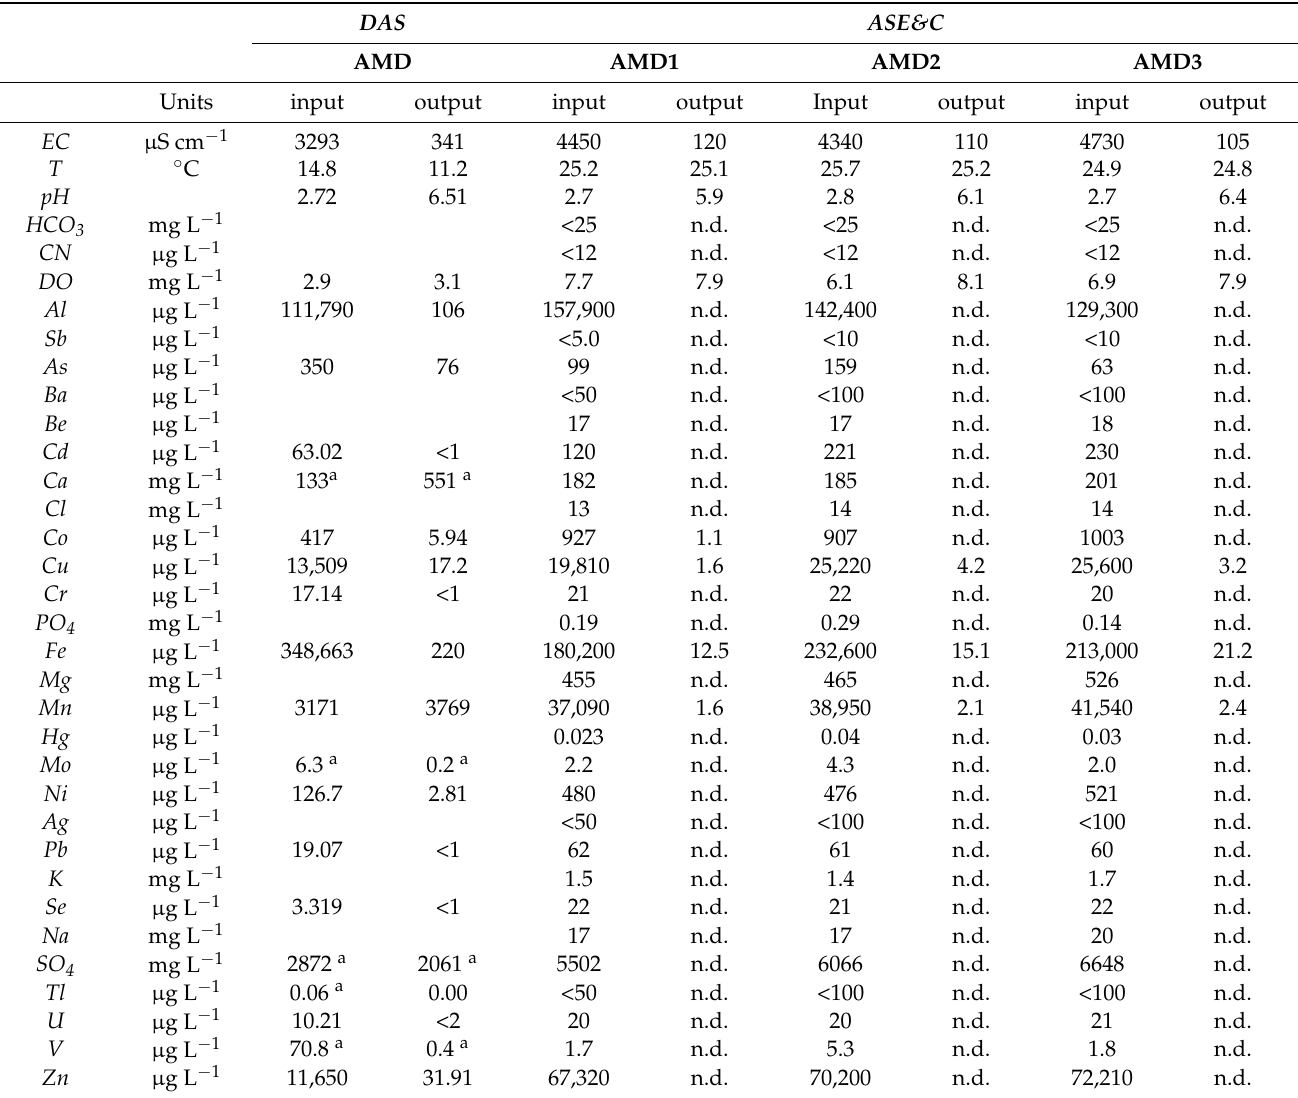
Table 1. Effluent characterization samples in the input (sample) and output (AMD treated) with the DAS and ASE&C